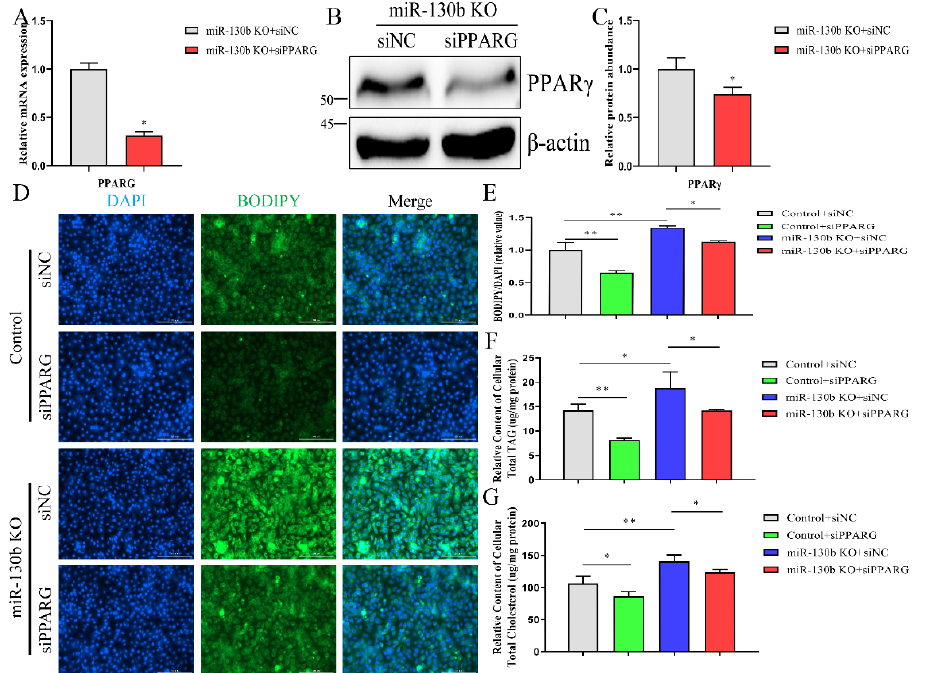
Figure 6. Knocking out miR-130b promotes lipid droplets, TAG, and cholesterol synthesis via tar- geting PPARG . ( A ) Abundance analysis of PPARG mRNA after interfering with its expression in miR-130b KO cells. ( B , C ) Detection of PPAR γ protein abundance in miR-130b KO cells transfected with siPPARG or siNC. ( D – G ) Detection of the contents of lipid droplets ( D , E ), TAG ( F ), and cho- lesterol ( G ) in miR-130b KO and control cells transfected with PPARG siRNA or NC. Data are dis- played as mean ± SEM. p < 0.05 and p < 0.01 are indicated as * and **.